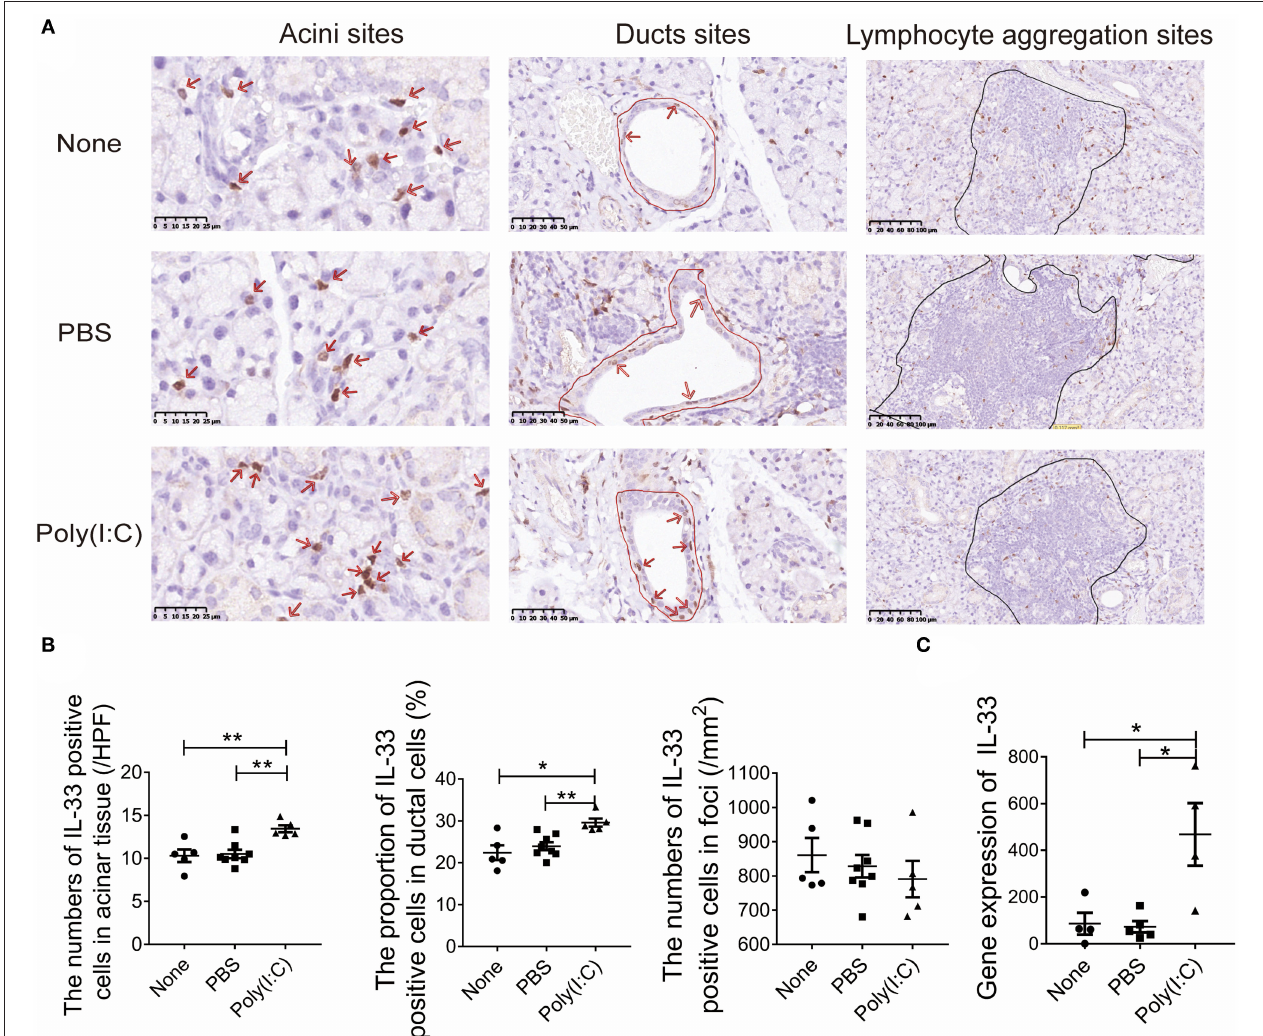
FIGURE 4 | Poly(I:C) intratracheal stimulation upregulated the expression of IL-33 in salivary gland. (A) Immunohistochemical staining for IL-33 expression in salivary gland ( × 400, × 400, × 200) ( n = 5–8 per group). (B) The number of IL-33 positive cells per high power field (HPF) in acini sites, the proportion of IL-33 positive cells to total ductal cells in ducts sites, the number of IL-33 positive counts in lymphocyte aggregation sites per square millimeter (mm 2 ). (C) The mRNA level of IL-33 in salivary gland ( n = 5, 5, 4). Data were presented as mean ± SEM, * p < 0.05, ** p <